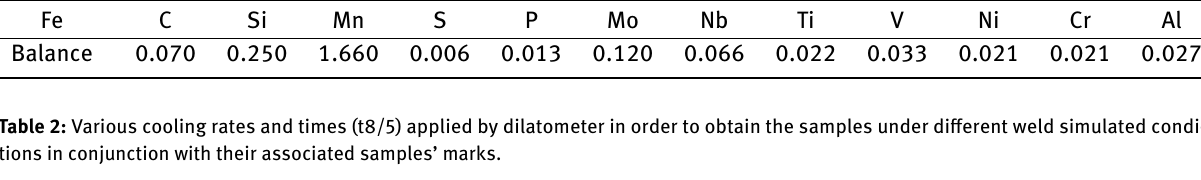
Table 1: Chemical composition of the investigated API 5L X-60 pipeline steel (in wt%). Fe C Si Mn S P Balance